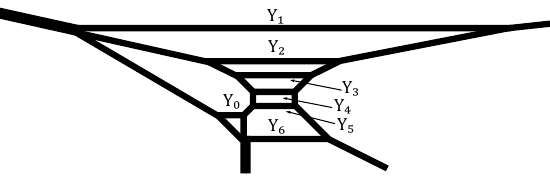
Figure 6 . A labeling of Young diagrams assigned to the horizontal lines in (cid:12)gure